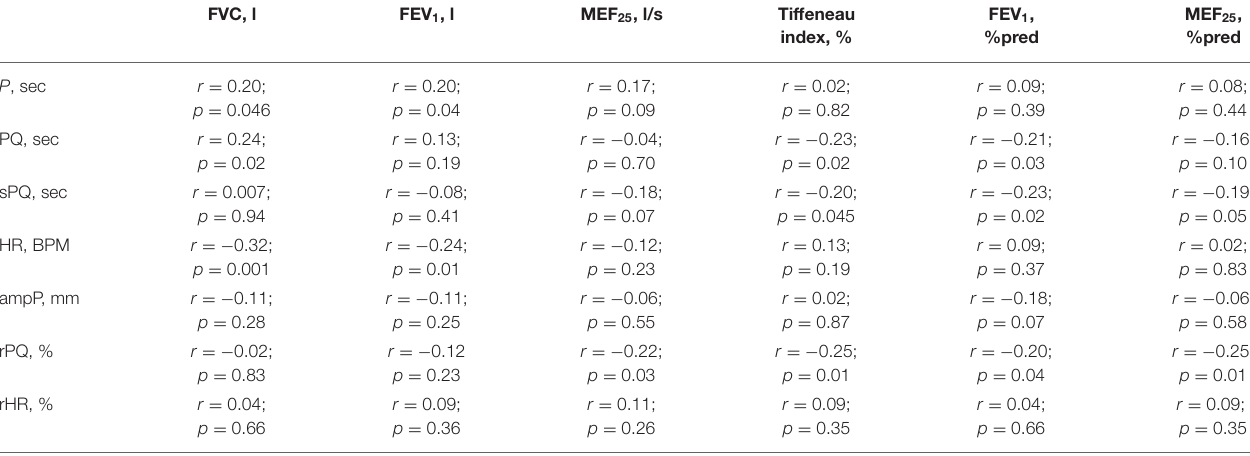
TABLE 4 | Relationship between spirometry parameters and ECG atrial component in children with BA. FVC, l FEV 1 ,